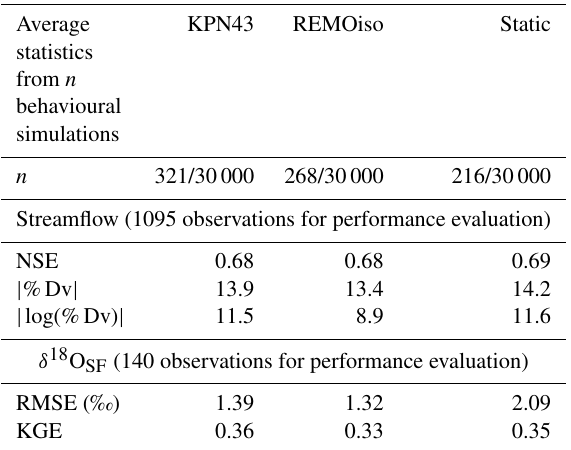
Table 5. Average simulation statistics from n behavioural simula- tions for streamflow and δ 18 O SF for the three model calibrations (using KPN43, REMOiso, and static